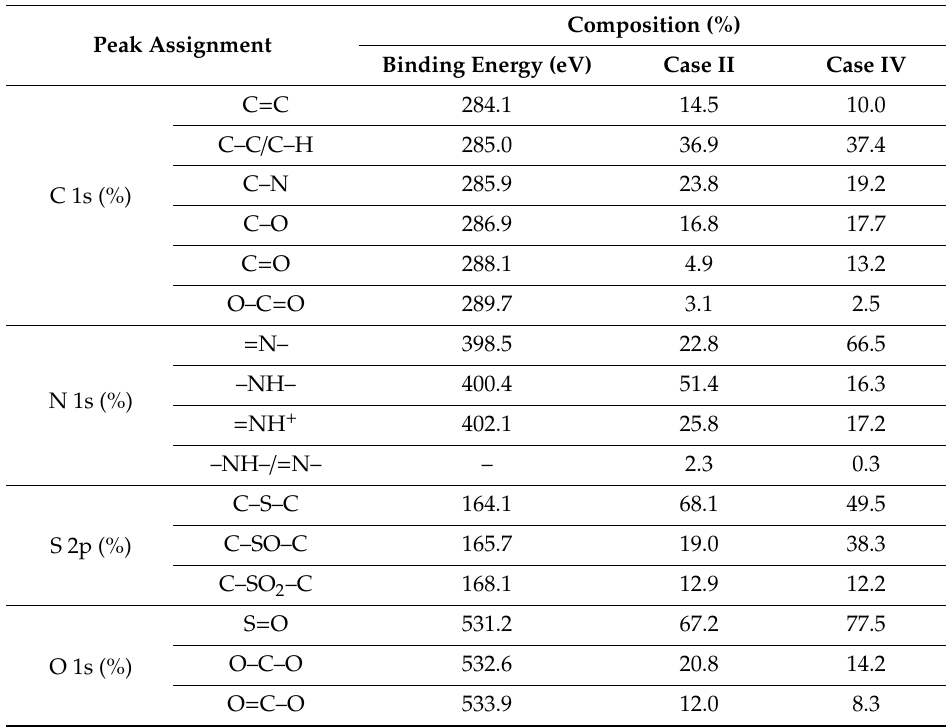
Table 5. Peak assignments (BE, eV) and envelope composition (%, total = 100) of C 1s, N 1s, S 2p, and O 1s peaks for chemical structure of TAC films deposited on glass substrates by APPJs polymerization technique at two di ff erent blending conditions of cases II (aniline 75% and thiophene 25%) and IV (aniline 25% and thiophene